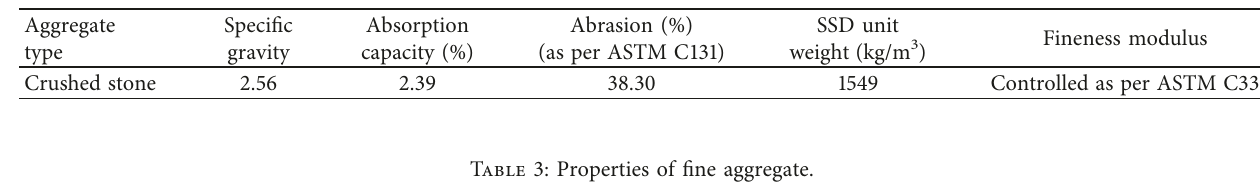
Table 2: Properties of coarse aggregate.